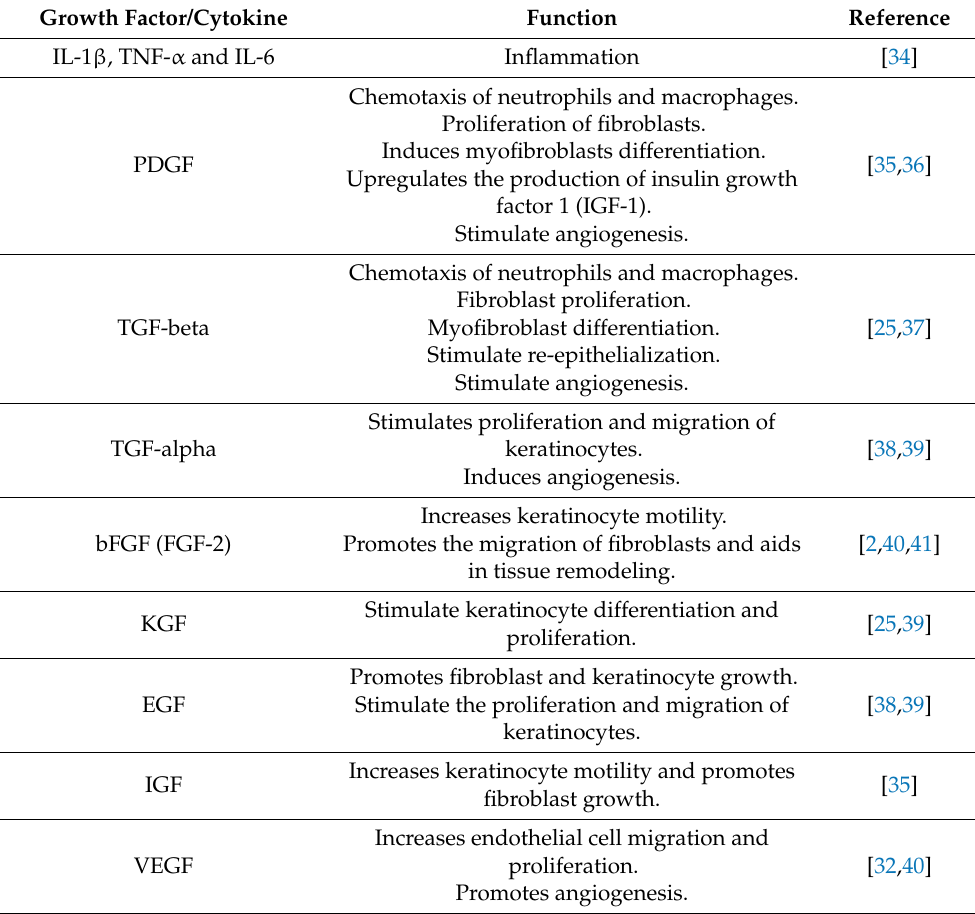
Table 1. Cytokines and growth factors involved in wound healing and their